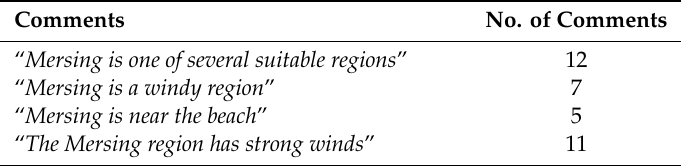
Table 5. Reasons why Mersing is a suitable region for wind and solar energy development. Comments